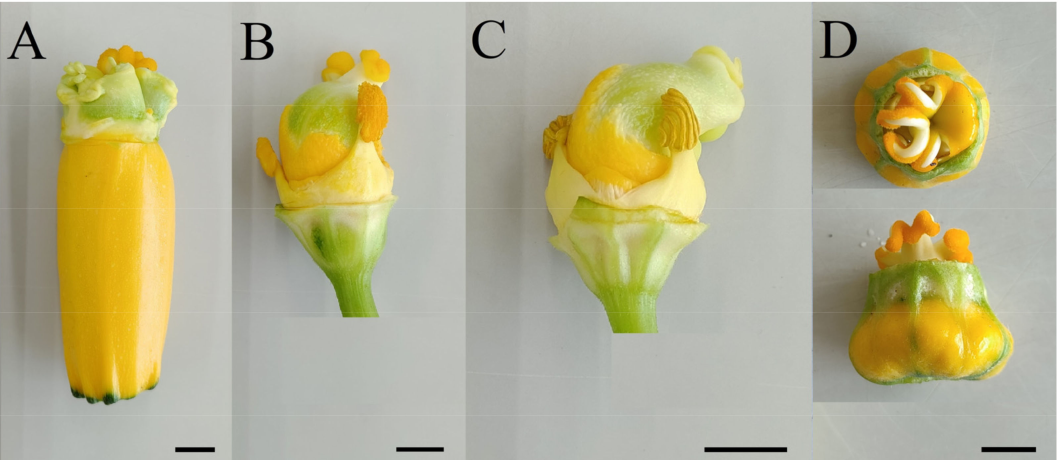
Figure 6. Abnormal female and gynandromorphic flowers of C. pepo (corolla removed): ( A ) abnormal female flower of courgette; ( B , C ) gynandromorphic flowers of courgette; ( D ) abnormal female flower of patisson. Scale bars = 1